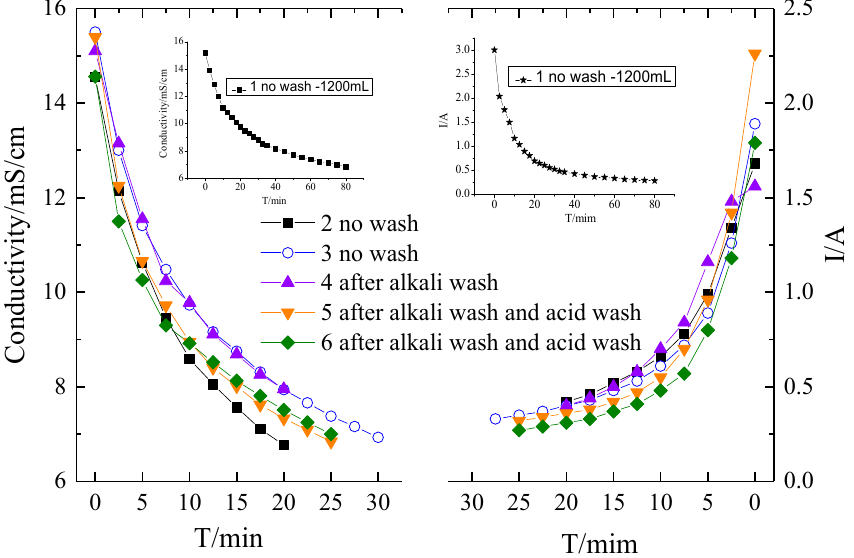
Figure 5. The conductivity and current evolution curves of the desalination process by different membrane washing strategies.